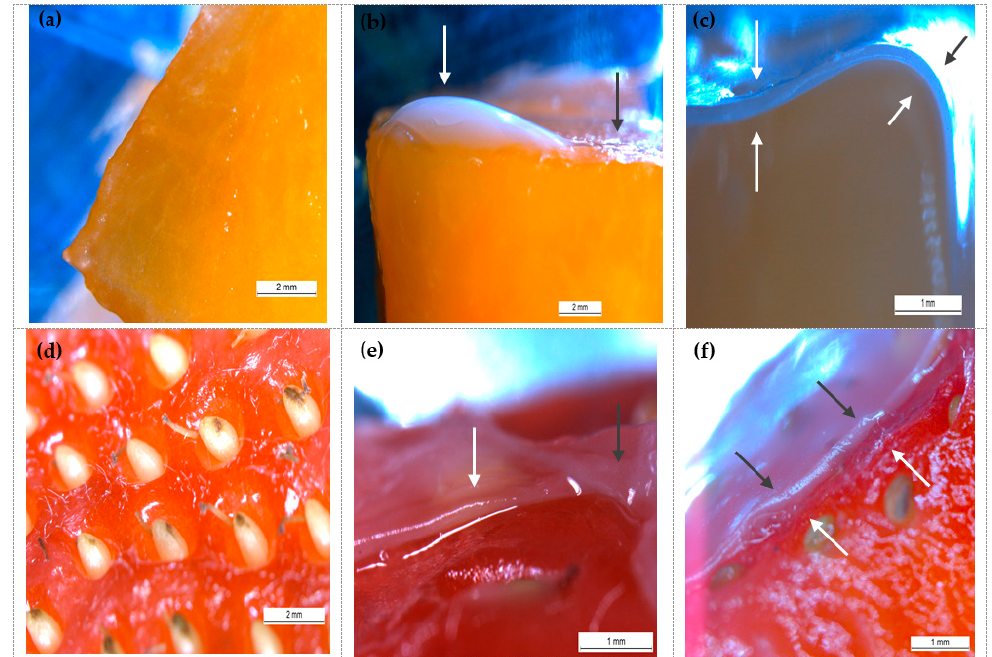
Figure 2. Stereomicroscope images of uncoated and coated fruits: ( a ) surface of uncoated cantaloupe; ( b ) cantaloupe surface coated with conventional method; ( c ) cantaloupe surface coated with novel method; ( d ) surface of uncoated strawberry; ( e ) strawberry surface coated with conventional method; ( f ) strawberry surface coated with novel method. Coating solution: 1.25% alginate + 2% glycerol + 0.2% sunflower oil + 1% span 80 + 0.2% tween 80. Gel formation was accomplished with a 2% calcium lactate solution. The color of the arrows does not designate anything and was only changed to increase visibility.